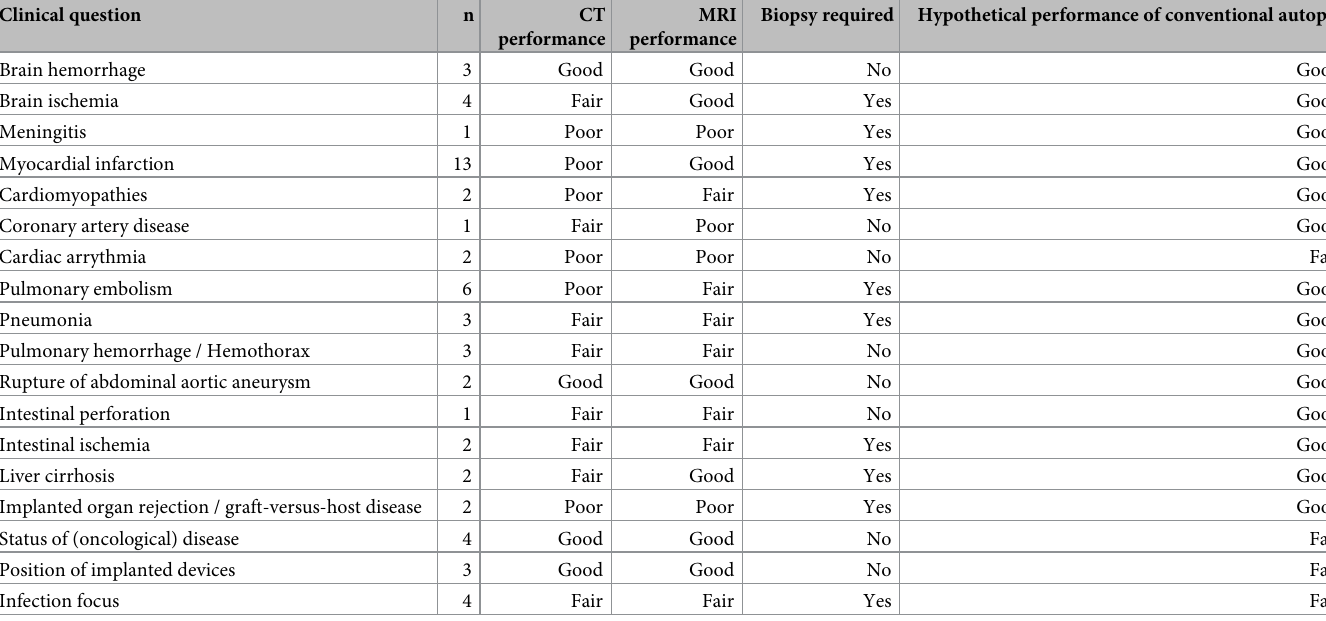
Table 4. Clinical utility of postmortem CT and postmortem MRI for specific clinical